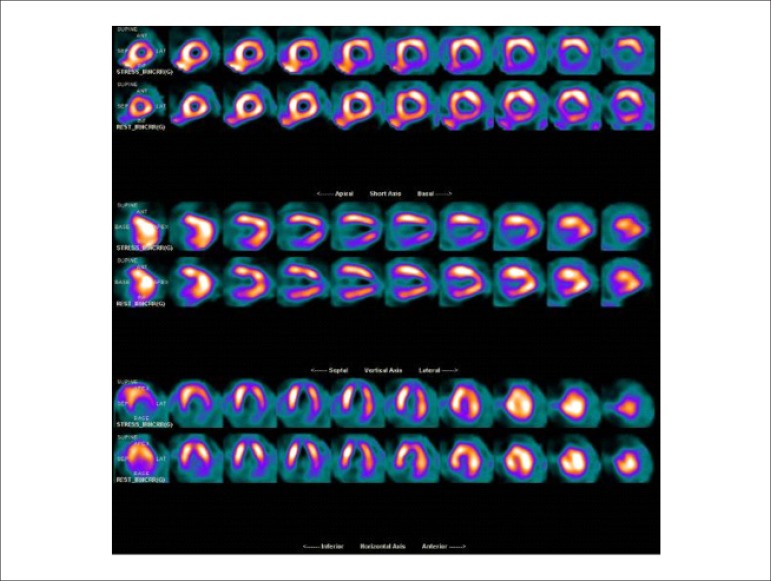
Case 7 - Myocardial perfusion scintigraphy showing significant perfusion abnormalities (notably following administration of dipyridamole, with partial improvement while resting) and dilation of the left ventricle. Image acquired with dedicated cardiac equipment (gamma camera), equipped with conventional sodium iodide crystals.